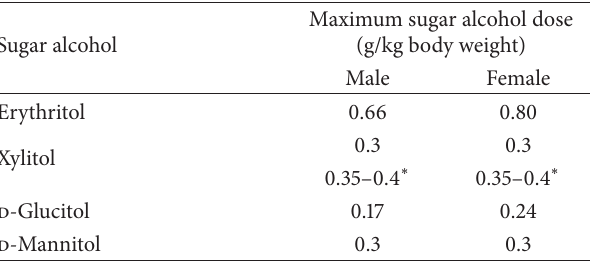
Table 2: Maximum bolus doses of some dietary sugar alcohols not causing catharsis. Based on de Cock